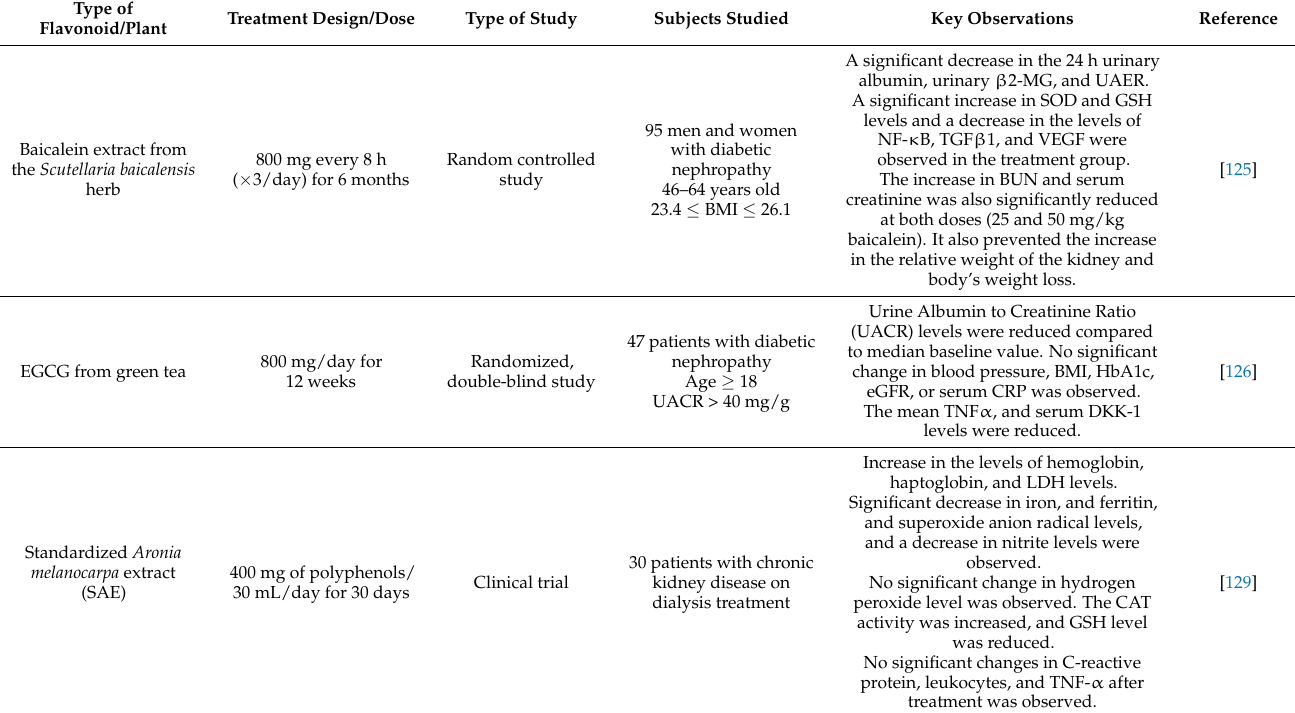
Table 2. Clinical trial data showing the effect of flavonoids on kidney